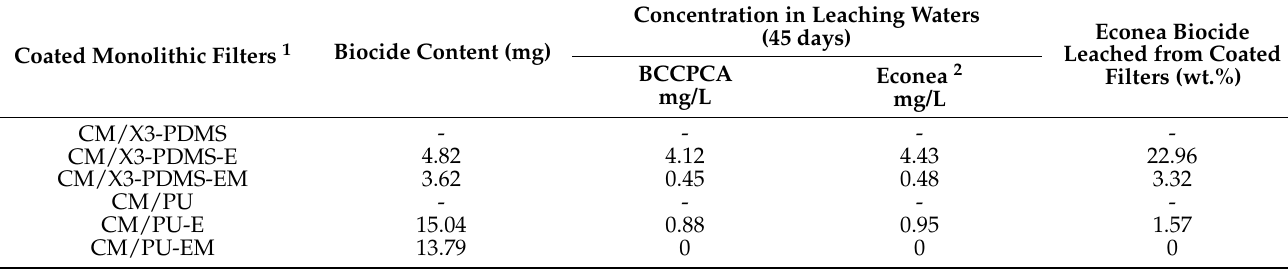
Table 3. Detected compound by UHPLC-MS/MS analyses in 45 days of leaching waters obtained from submerged monolithic-coated filters with biocidal polydimethylsiloxane (PDMS) and polyurethane (PU)-based coatings, prepared by direct incorporation of the biocide, CM/X3-PDMS-E and CM/PU-E, or by biocide grafting, CM/X3-PDMS-EM and